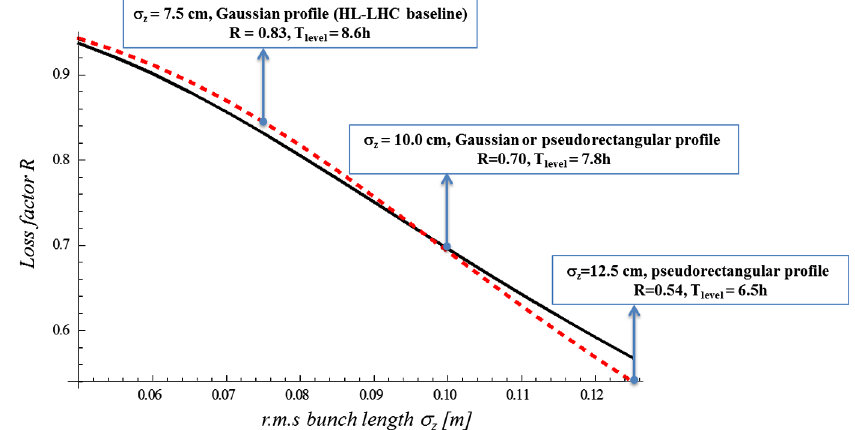
FIG. 2. Generalized luminosity loss factor R [see Eq. (8)] at the end of the luminosity leveling process (full crabbing, no crab-kissing, β (cid:1) ¼ 15 cm) as a function of the r.m.s. bunch length σ z [m], including the hour-glass effect, considering the RF curvature of the crab- cavity deflecting field, and using the HL-LHC parameter set given in Table I (except for the bunch length). The solid line assumes a purely Gaussian bunch profile (single harmonic RF system), while the dashed curve corresponds to the case of a double harmonic RF system, which is simulated by considering the pseudorectangular distribution parametrized in Eq. (19).